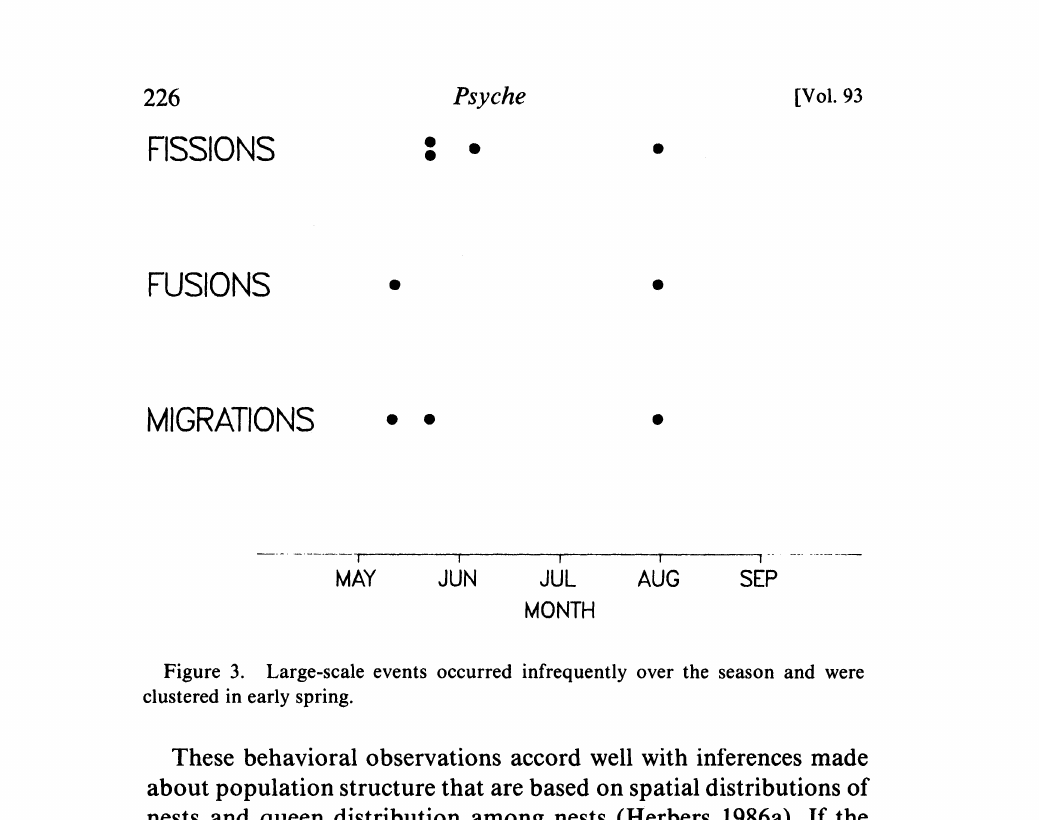
Figure 3. Large-scale events occurred infrequently over the season and were clustered in early